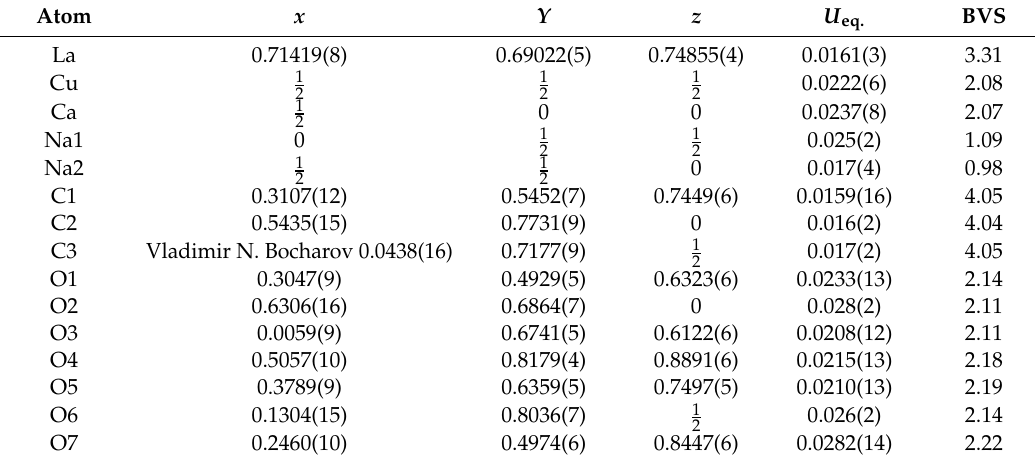
Table 2. Atomic coordinates, isotropic displacement parameters (Å 2 ), and bond-valence sums (BVS, in valence units (v.u.)) for paratooite-(La).